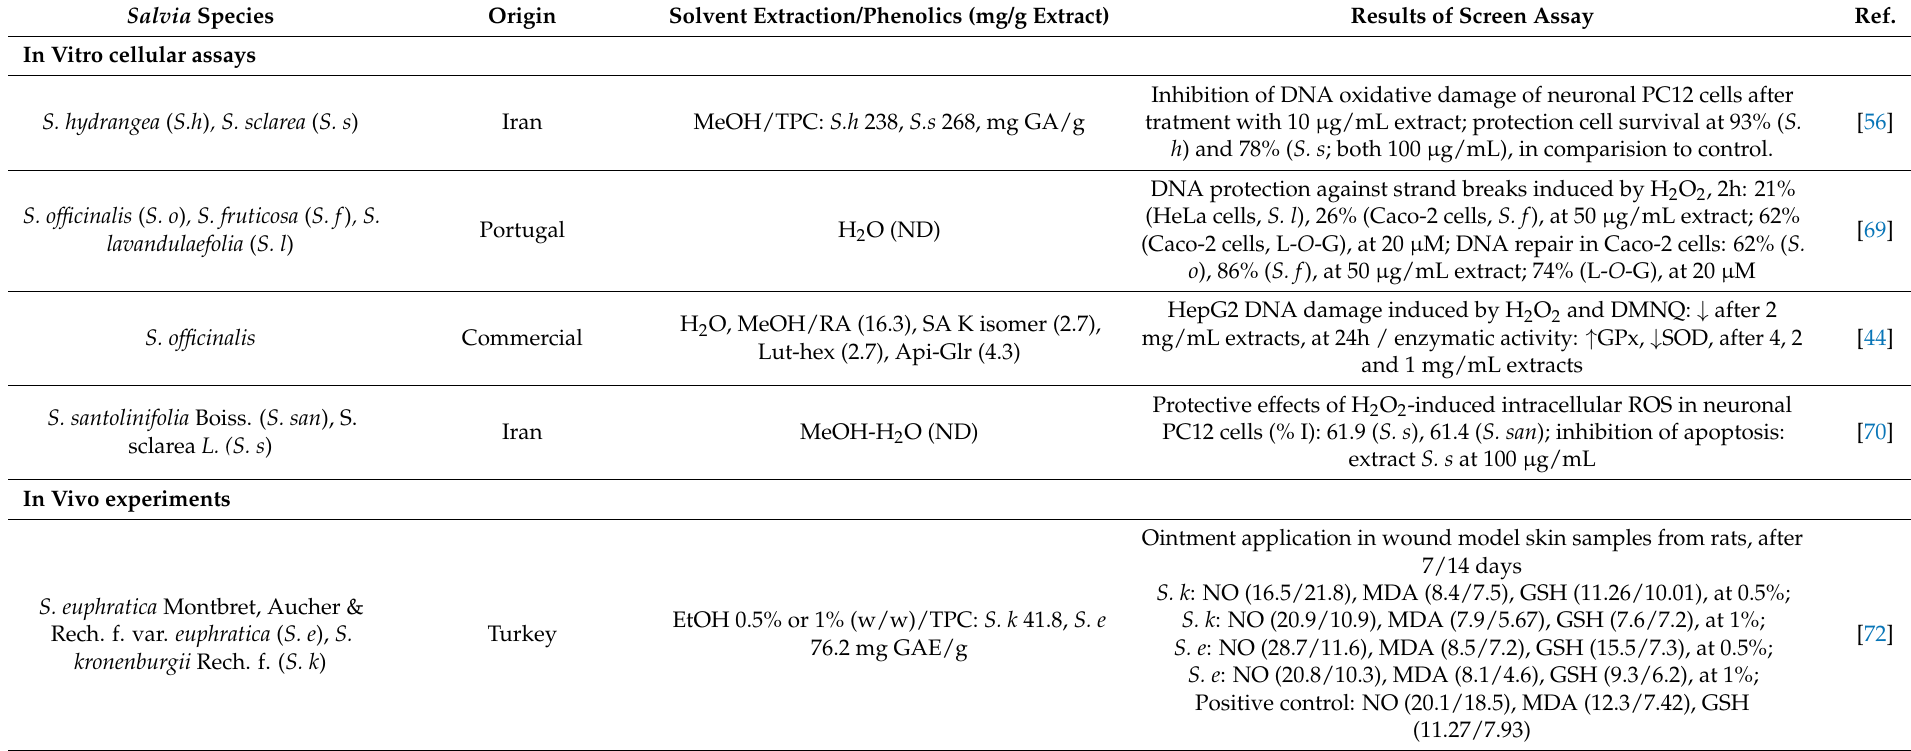
Table 2. Antioxidant properties of phenolic rich extracts of distinct Salvia species (in vitro cellular assays and in vivo